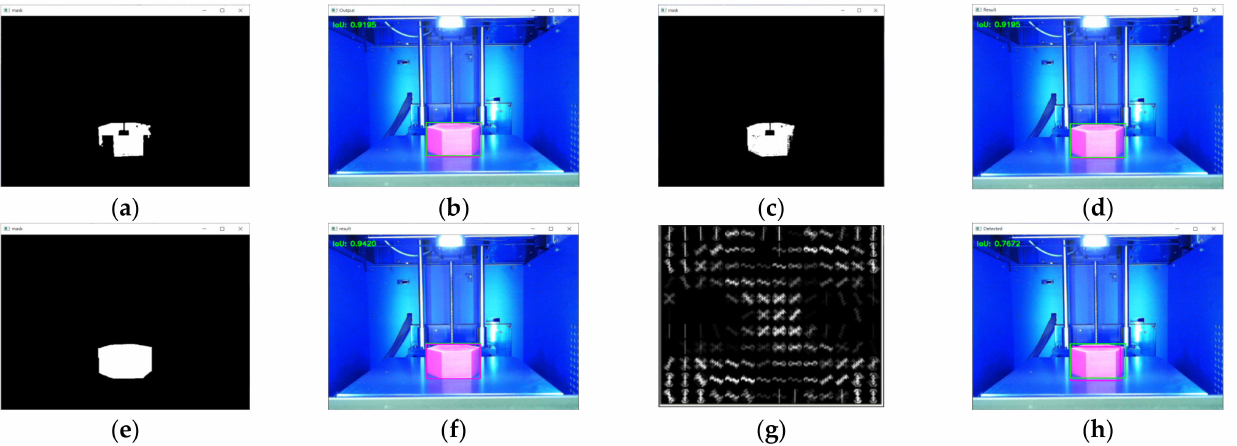
Figure 9. Test 2 product result of background subtraction by the Otsu and GMM algorithms: ( a ) foreground mask of the background subtraction by the Otsu algorithm; ( b ) test result of the background subtraction by the Otsu algorithm; ( c ) foreground mask of the background subtraction by the GMM algorithm; ( d ) test result of the background subtraction by the GMM algorithm; ( e ) foreground mask of the GrabCut algorithm; ( f ) test result of the GrabCut algorithm; ( g ) gradient vector of the HOG algorithm; ( h ) test result of the HOG